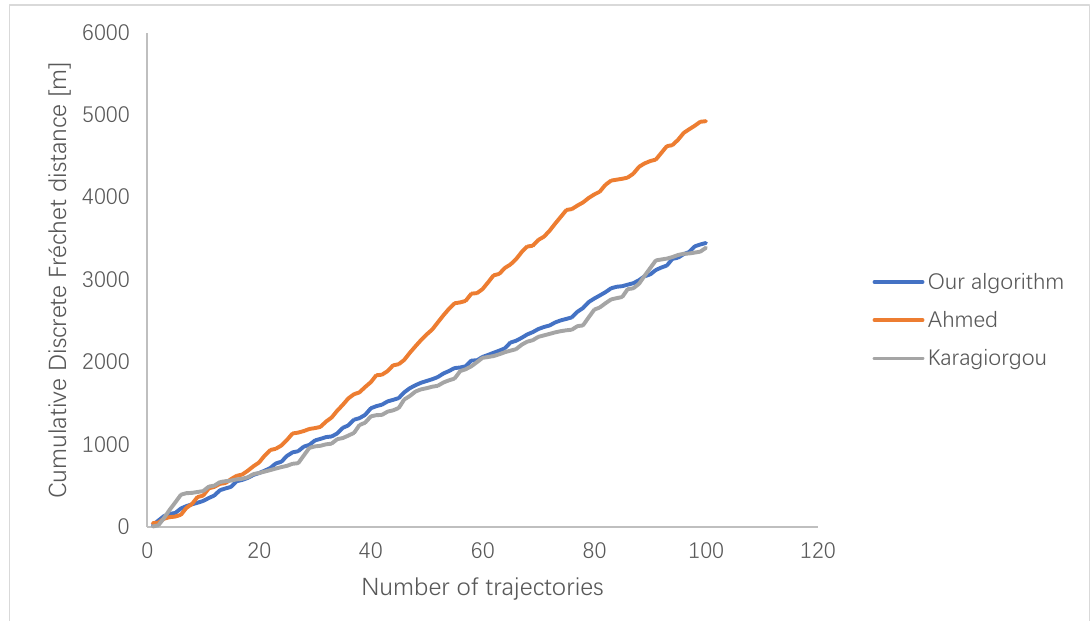
Figure 17. Comparison between road network and high-definition satellite map ( ε = 9 ).